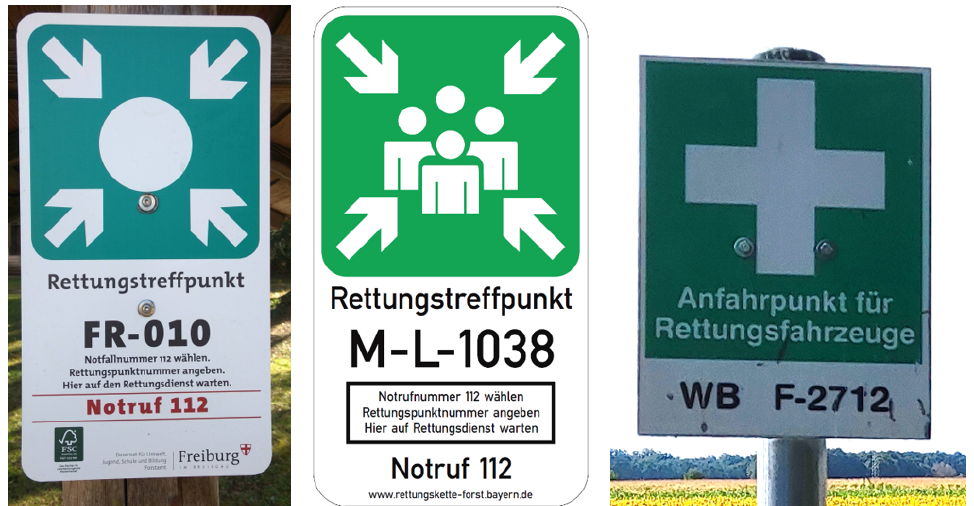
Figure 2. Examples of the signage for rescue points in the different federal states: Baden-Württemberg ( left ), Bavaria ( middle ), and Saxony-Anhalt ( right